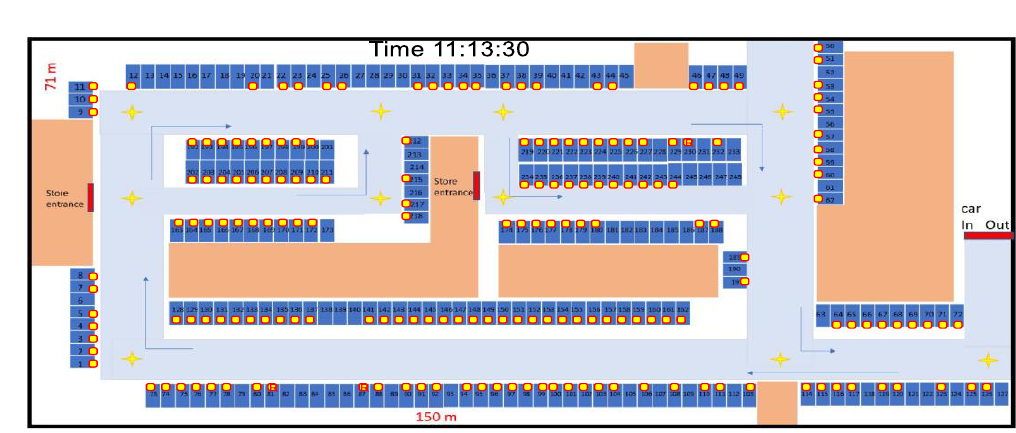
Figure 2: A simulation model using a real parking lot in Japan contains 248 parking points. The small yellow squares indicate an occupied parking point.